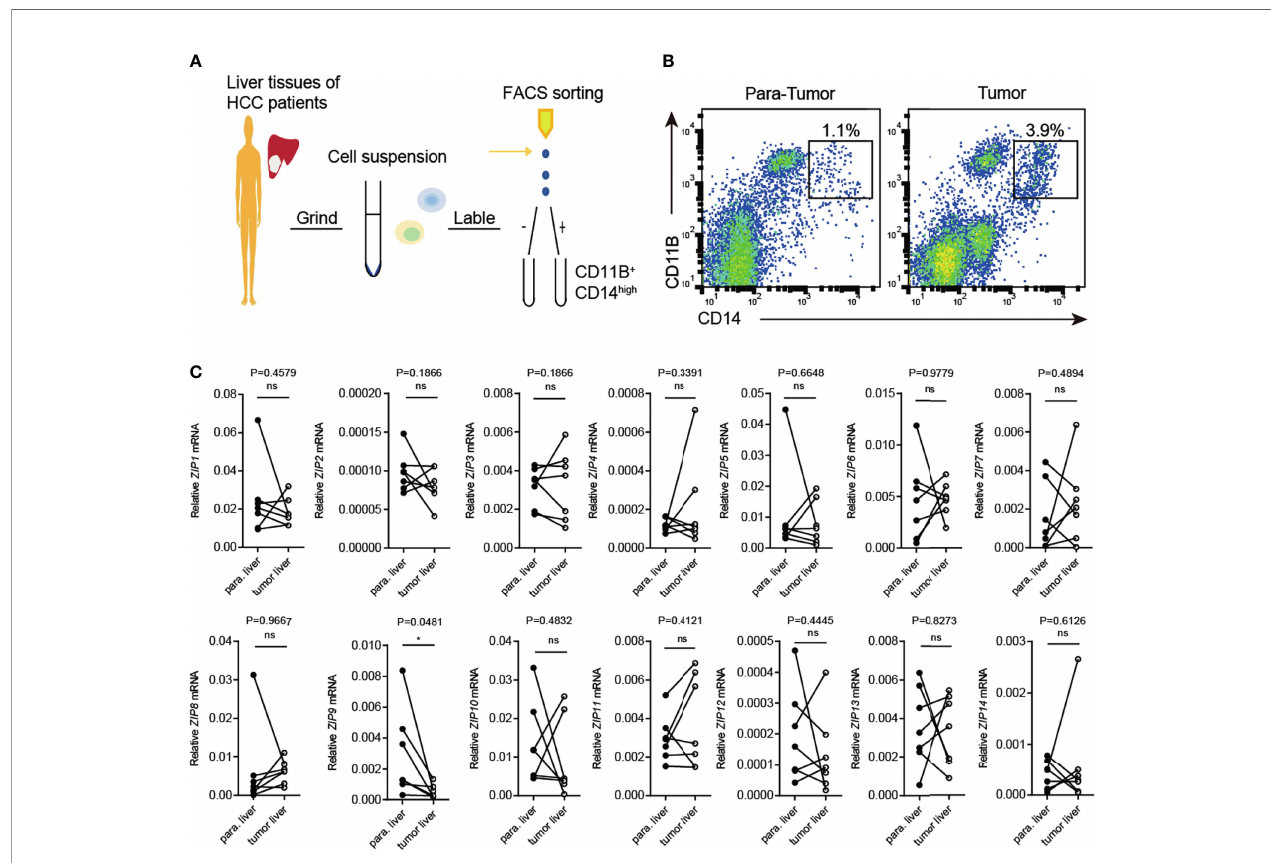
FIGURE 6 | Transcription of Zip9 isdownregulated in HCC patients-derived TAMs. (A) FACS protocol was used for isolating HCC patients-derived TAMs. (B) Human liver cancer tissues and paracarcinoma liver tissues were digested,stained for CD14, CD11B and then analyzed by fl ow cytometry. (C) The mRNA levelsof ZIPs in TAMsisolated from human liver cancer tissues and paracarcinoma liver tissues were detectedby RT-PCR (n= 7). The black points represent the individual paracarcinoma liver tissue, and the black circles represent the liver cancer tissue. The expressed values were calculated bythe 2 − D CT method. *P < 0.05, ns, not signi fi cant. The representative data fromat leastthree independent experiments are shown. Data were determined with 2-tailed unpaired Student ’ s t test between 2